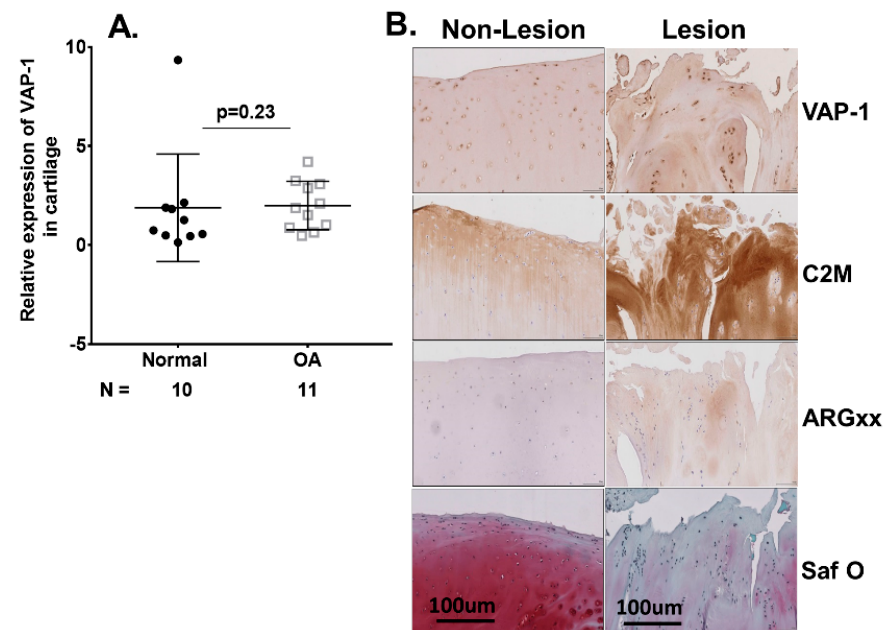
Figure 2. ( A ) RT-qPCR analysis of VAP-1 mRNA in 10 normal and 11 OA individual cartilage specimens from knee joints. Symbols represent individual subjects; bars show the mean and standard deviation. N values are the number of individuals from whom samples were available for testing. p values were determined by nonparametric Mann–Whitney test; ( B ) Immunohistochemical analysis of VAP-1 in lesional and non-lesional OA knee cartilage. Lesion and non-lesion OA knee cartilage samples ( n = 3) from same individual undergoing total knee replacement surgery were collected, sectioned, and stained for VAP-1 with vectastain reagents (Vector Laboratories, Burlingame, CA, USA). Representative VAP-1, C2M, and ARGxx immunostaining images are shown. Slides were scanned at 40 × and micrographs were taken at a magnification of 20 × . Safranin O staining showed loss of extracellular matrix and cartilage degeneration in lesion compared with the non-lesion area of the same patient. p values were calculated by the nonparametric Mann–Whitney U test between the control and OA groups. The images are shown with scale bar 100 µ m. N : number of individuals whose samples were tested. Serum sVAP-1 levels were lower in SKOA patients and inversely associated with radiographic severity. We determined the baseline serum sVAP-1 levels in SKOA ( n = 372) and non-OA subjects ( n = 23) from the NYU cohort. SKOA patients had significantly lower sVAP-1 levels than controls (430.00 ± 115.50 vs. 569.90 ± 178.01 ng / mL, respectively; p ≤ 0.002) and retained significance even after adjustment for covariates age, gender, and BM (Table 1 and Figure 3A). We next determined the correlation of serum sVAP-1 levels with radiographic KL grade and found that sVAP-1 levels were significantly lower in radiographically advanced KL4 grades ( p = 0.022; Figure 3B). We further determined the association of serum sVAP-1 with radiographic severity and found that sVAP-1 were lower in KL3 / 4 than in KL1 / 2 (412.6 ± 102.7 vs. 437.6 ± 116.8 ng / mL, respectively; p = 0.02; Figure 3C) SKOA patients. Since OA prevalence increases significantly with age groups of ≥ 50 years [22,23], we next analyzed sVAP-1 levels by dichotomizing the sample into age groups of ≤ 51 and ≥ 51 years. Serum sVAP-1 levels were significantly higher in SKOA patients of ≥ 51 years than in patients ≤ 50 years of age (437.86 ± 111.13. vs. 396.50 ± 128.0 ng / mL, respectively; p = 0.009; Figure